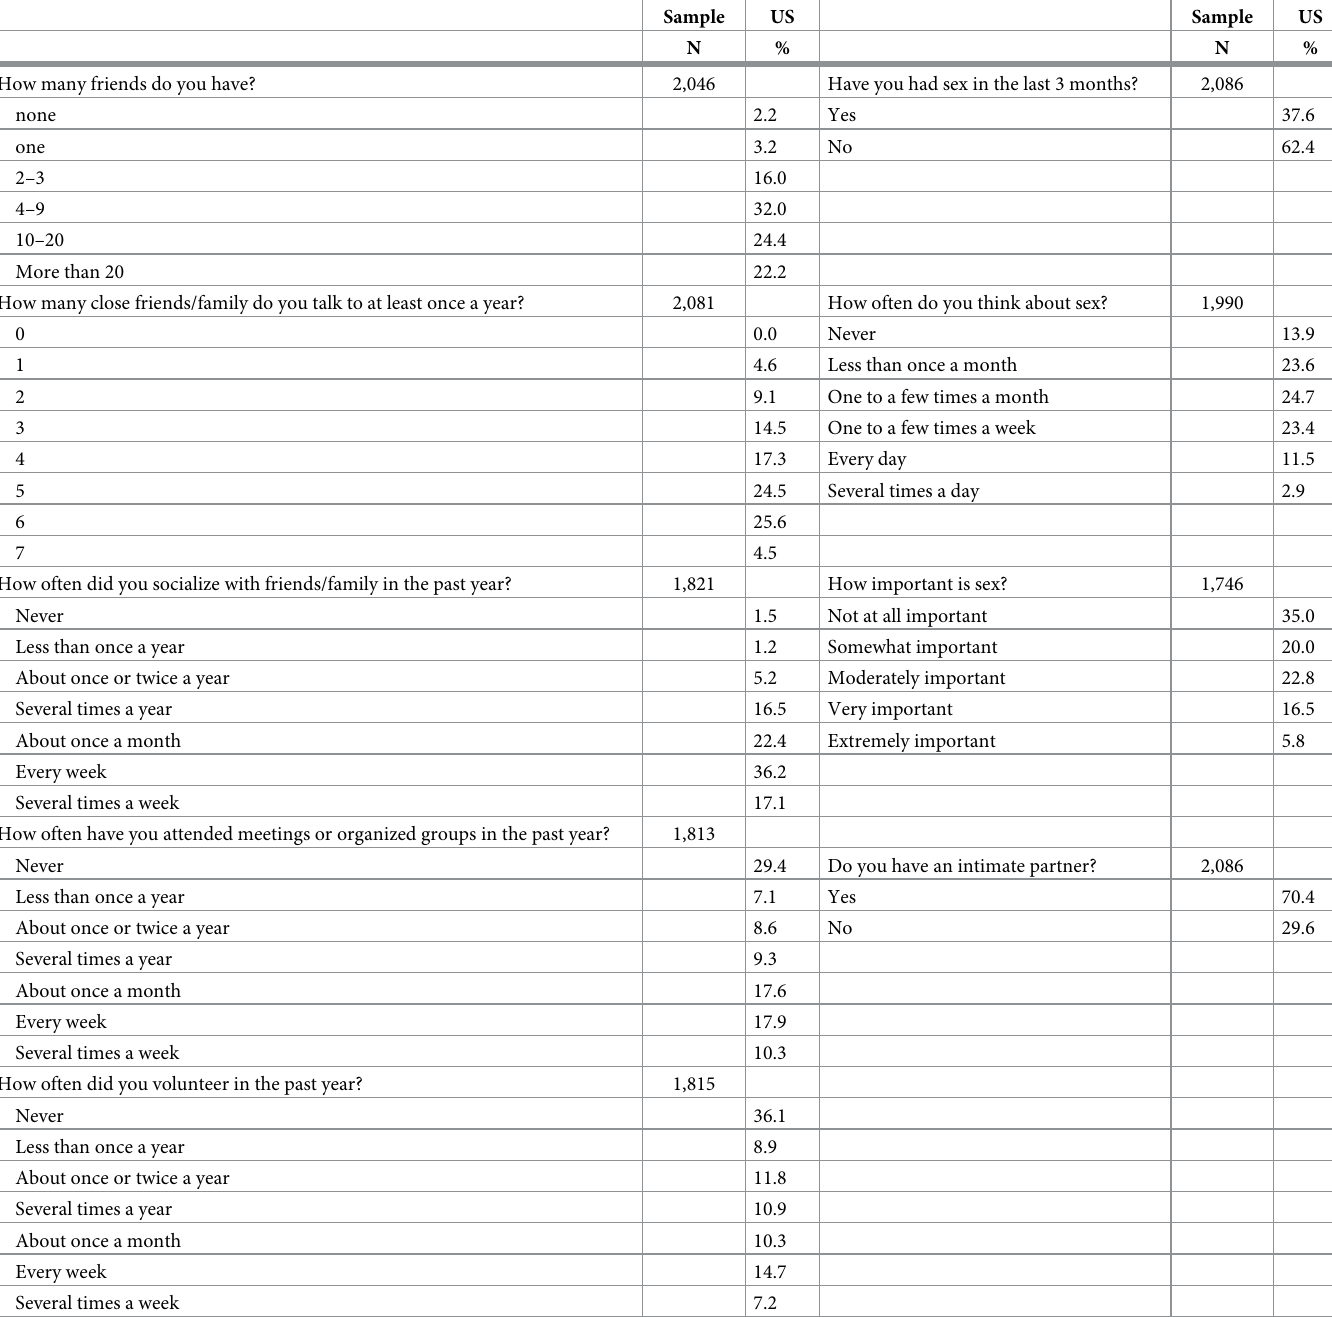
Table 2. Distributions of social life and sexual behavior among older US adults living at home. (NB Tables are large and at the end of the manuscript). Sample US Sample US N % N